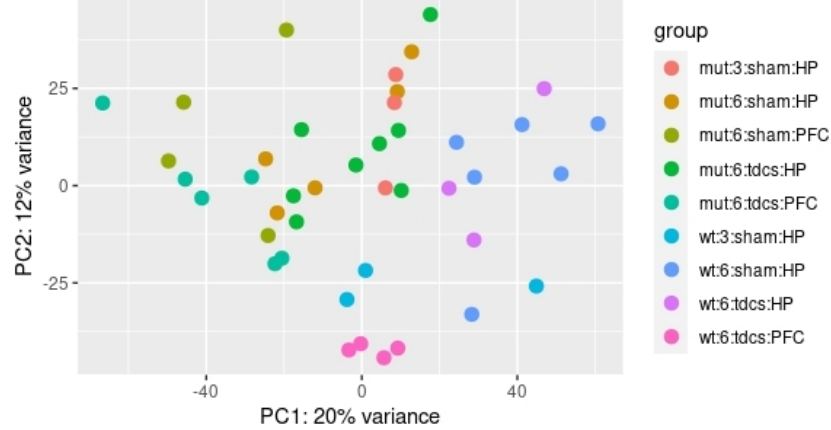
Figure 2. Scatterplot of the Principal Component Analysis.